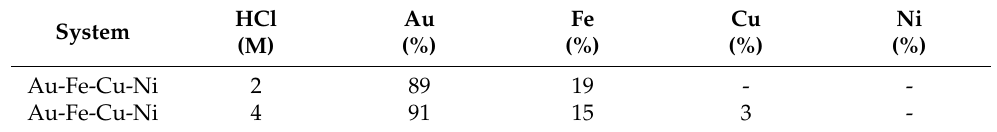
Table 12. Percentages of metal extraction from multi-elemental